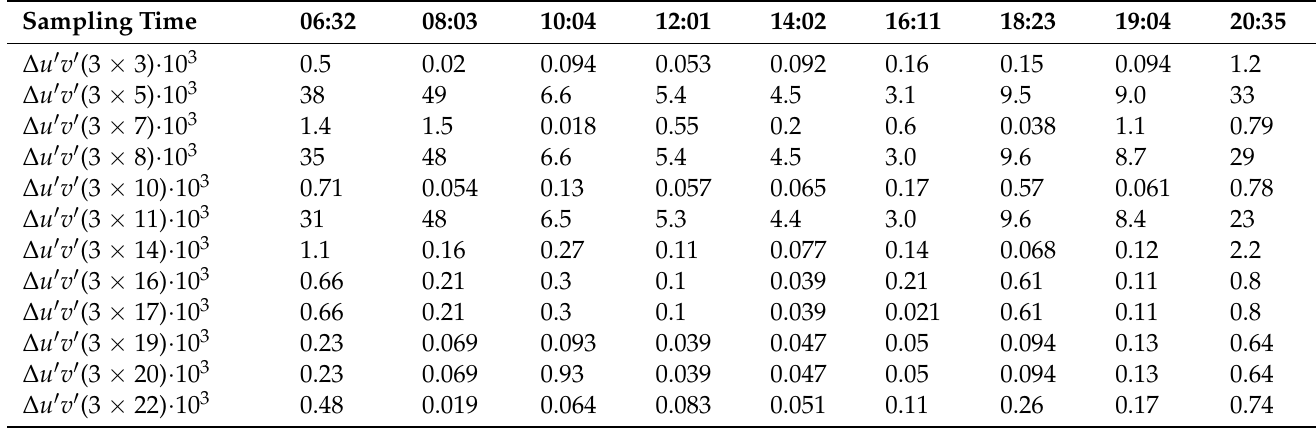
Figure 11. Training set of measured daylight spectra and visualization of the CIE model performance. ( a ) Daylight spectra as measured in Darmstadt, Hessen, Germany (GPS coordinates 49°51 (cid:48) 20.772 (cid:48)(cid:48) N, 8°39 (cid:48) 12.528 (cid:48)(cid:48) E) on 19 August 2020 from sunrise (6:22 a.m.) to sunset (8:45 p.m.). ( b ) Reconstructed daylight spectra from color sensor readouts by applying the CIE daylight model. ( c ) Spectral ratios between the original measurements and the reconstructed spectra. ( d ) Color differences ∆ u (cid:48) v (cid:48) between measured and reconstructed spectra. Table 5. Remaining color differences after optimization for different sizes of the daylight-specific transformation matrix applied to the respective training set of measured daylight spectra. Note that only a small, but representative selection of different daylight spectra denoted by their sampling times is shown